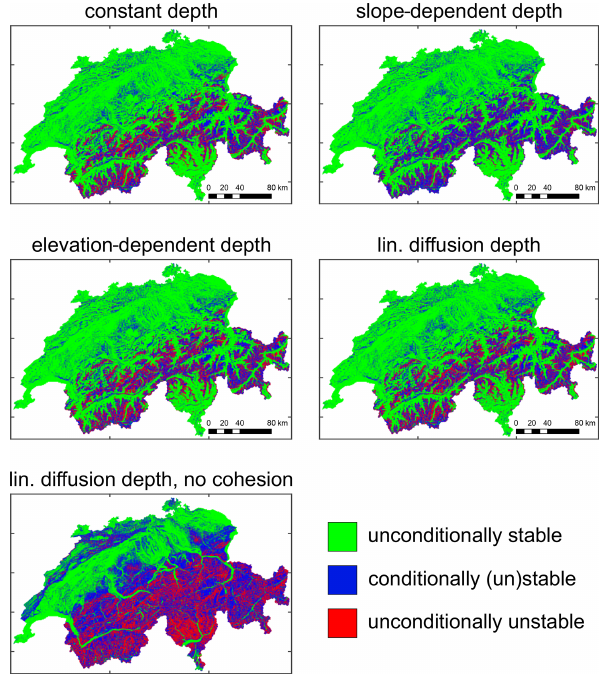
Figure 3. Maps of (un)conditionally (un)stable regions of Switzer- land obtained from the two factor of safety limiting cases (soil com- pletely wet or dry) and the different soil depth models. Panel in the bottom row is the reference case obtained with the linear diffusion model neglecting cohesion ( c =